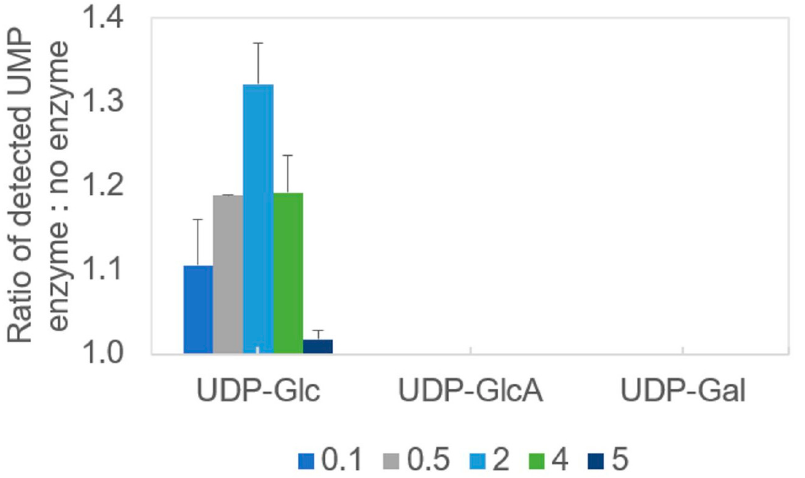
Figure 4. Determination of the donor specificity of recombinant PssA phosphoglycosyltransferase. The colored bars represent the averaged results of two replicates for a given protein amount indicated in the legend at the bottom ( µ g), for which the ratio of the UMP detected in the complete reaction to the respective negative control (no enzyme) was calculated—thus the X -axis intersects the Y -axis at 1.0. Error bars represent standard